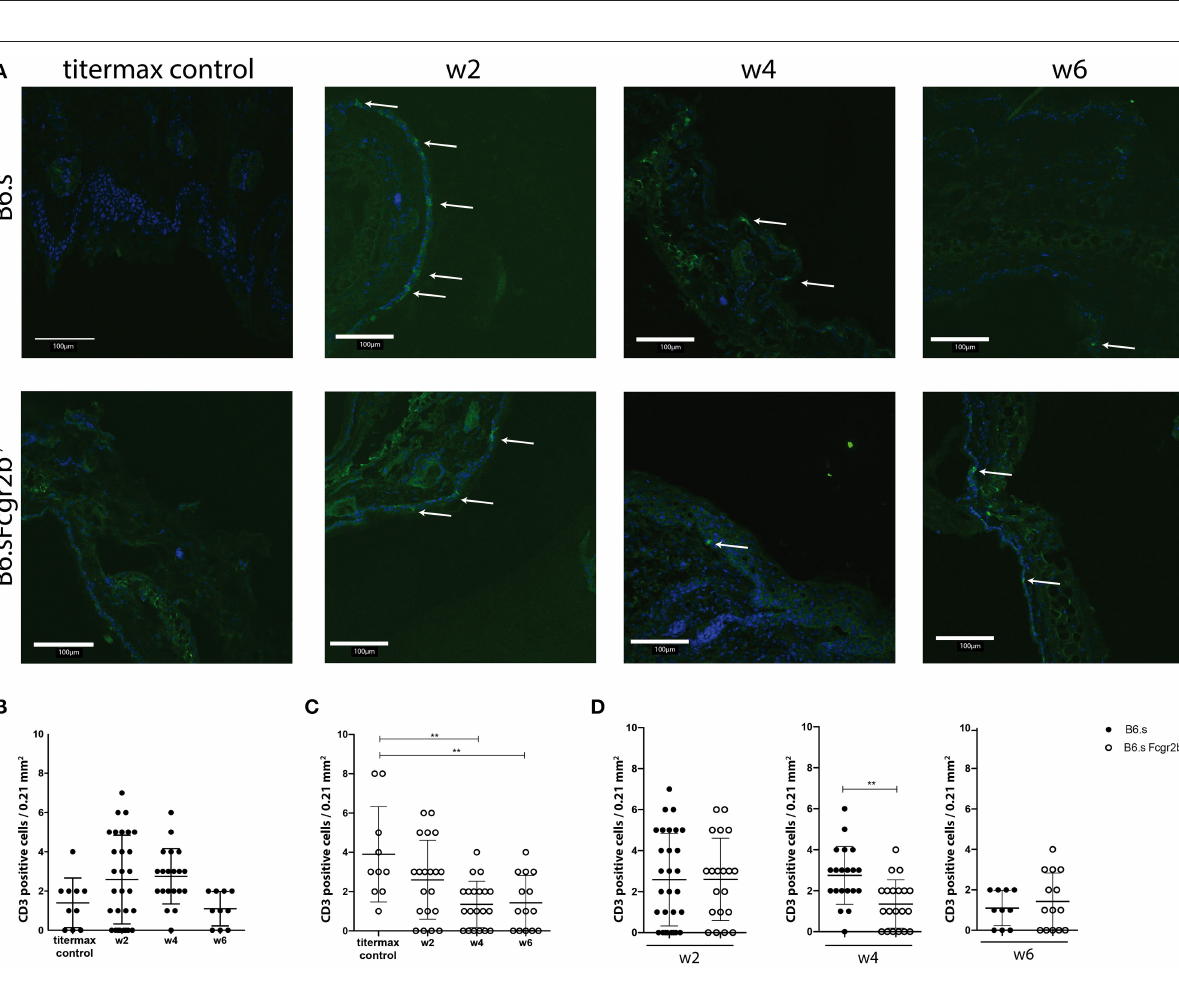
FIGURE 5 | CD3 + numbers in the skin of B6.s wt and B6.s- Fcgr2b − / − mice. (A) Presence of CD3 + T cells in the skin of B6.s wt and B6.s- Fcgr2b − / − mice 2, 4, and 6 weeks after immunization with vWAF2 antigen. Pictures show immunofluorescence staining from ear sections (green = CD3 + T cells; blue = DAPI). Positive signals are indicated by arrows. (B,C) Quantitative evaluation of CD3 + T cells in 0.21 mm 2 sections of B6.s wt (B) and B6.s- Fcgr2b − / − mice (C) during the 6 weeks observation period at weeks 2, 4, and 6. . (D) Comparison of the CD3 + T cells numbers in skin of B6.s and B6.s- Fcgr2b − / − mice at week 2 (left panel), 4 (middle panel), and 6 (right panel). Pictures were analyzed via ImageJ. Data in b-d are shown as scatter blot with mean ± SEM. Differences between week 2, 4, and 6 in (B,C) were analyzed by non-parametric one-way ANOVA test. Differences between B6.s and B6.s- Fcgr2b − / − mice (D) were evaluated by unpaired Student’s t -test (** p < 0.01).